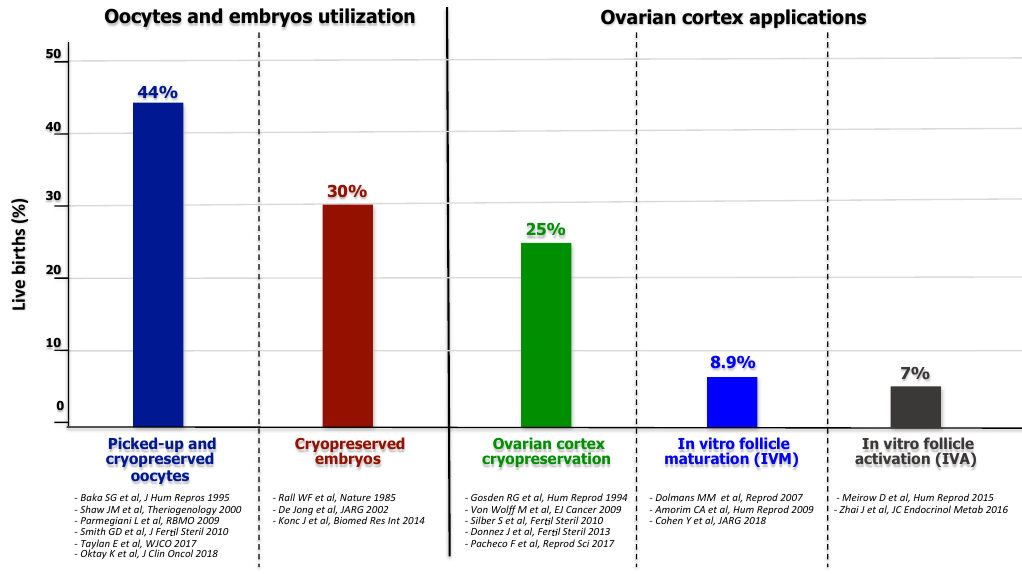
Figure 3. Live birth rates obtained by traditional oocyte pick-up and cryopreservation (left) and novel techniques using ovarian cortex biopsies (right), as reported in literature.